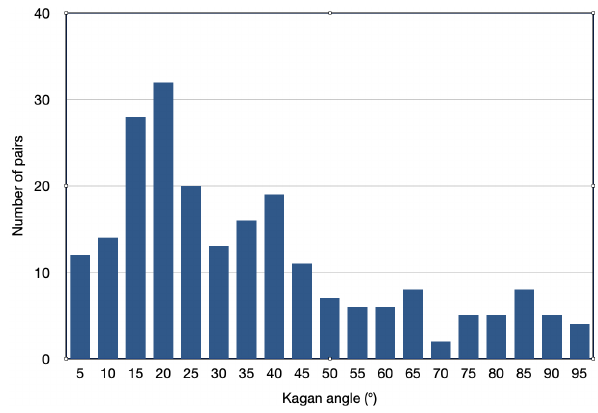
Figure 7. Kagan angle between the preferred solution and the al- ternative FPSs reported in our